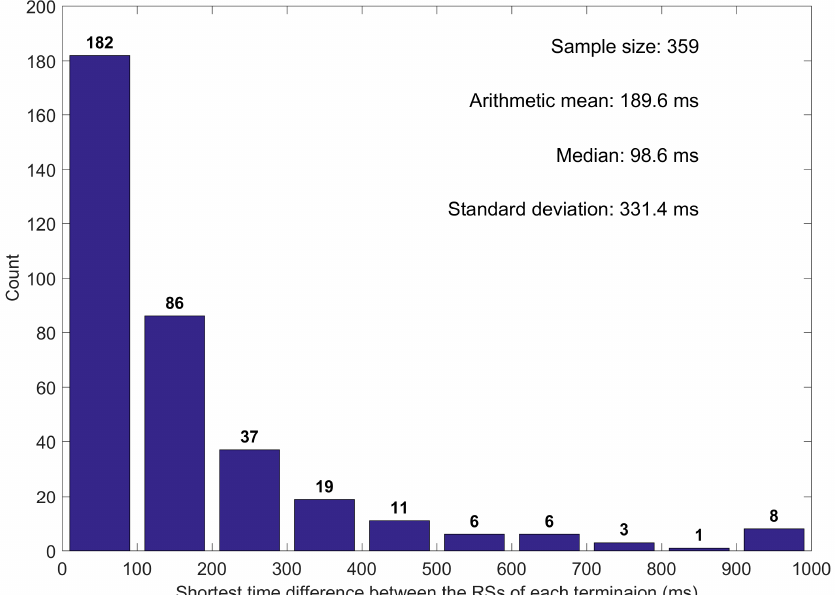
Figure 8. Histogram of the shortest time difference between the strokes at different terminations.